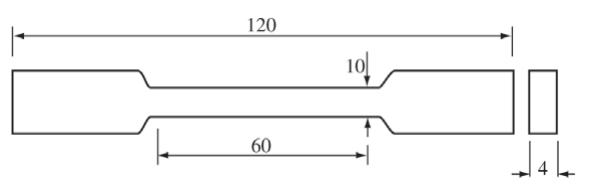
Figure 1. Tensile specimens. All dimensions are in